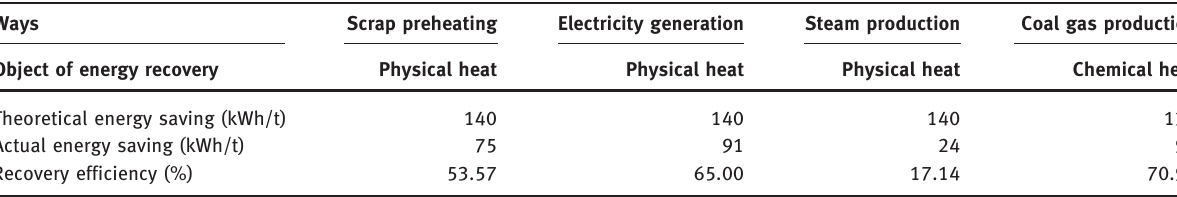
Table 1: Contrast of the four kinds of utilization of furnace gas waste heat. Ways Scrap preheating Electricity